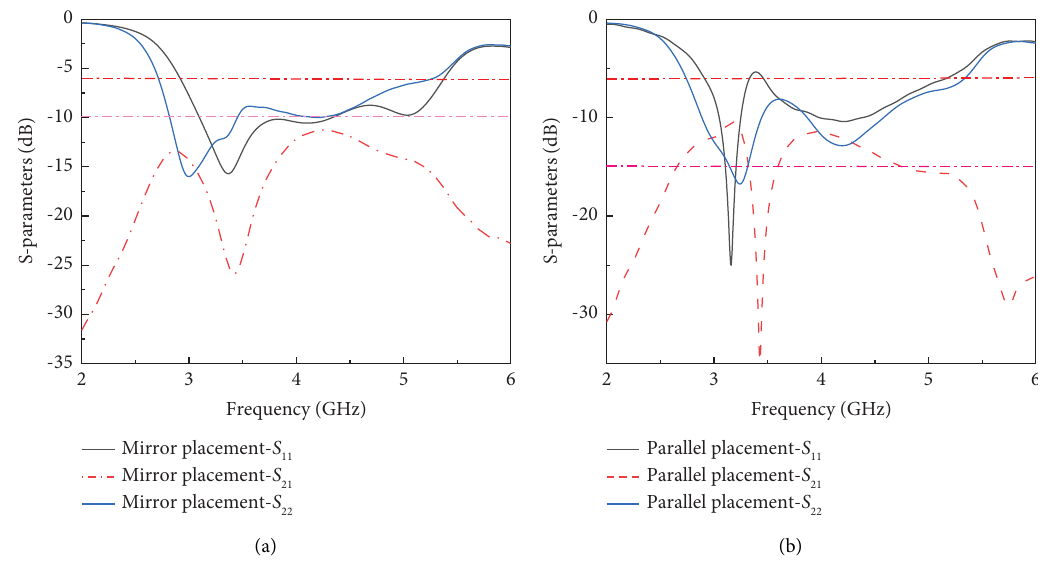
Figure 6: Simulated S -parameters with diferent arrangements: (a) S -parameters of two-element antennas in parallel arrangement; (b) S -parameters of two-element antennas in mirror arrangement.